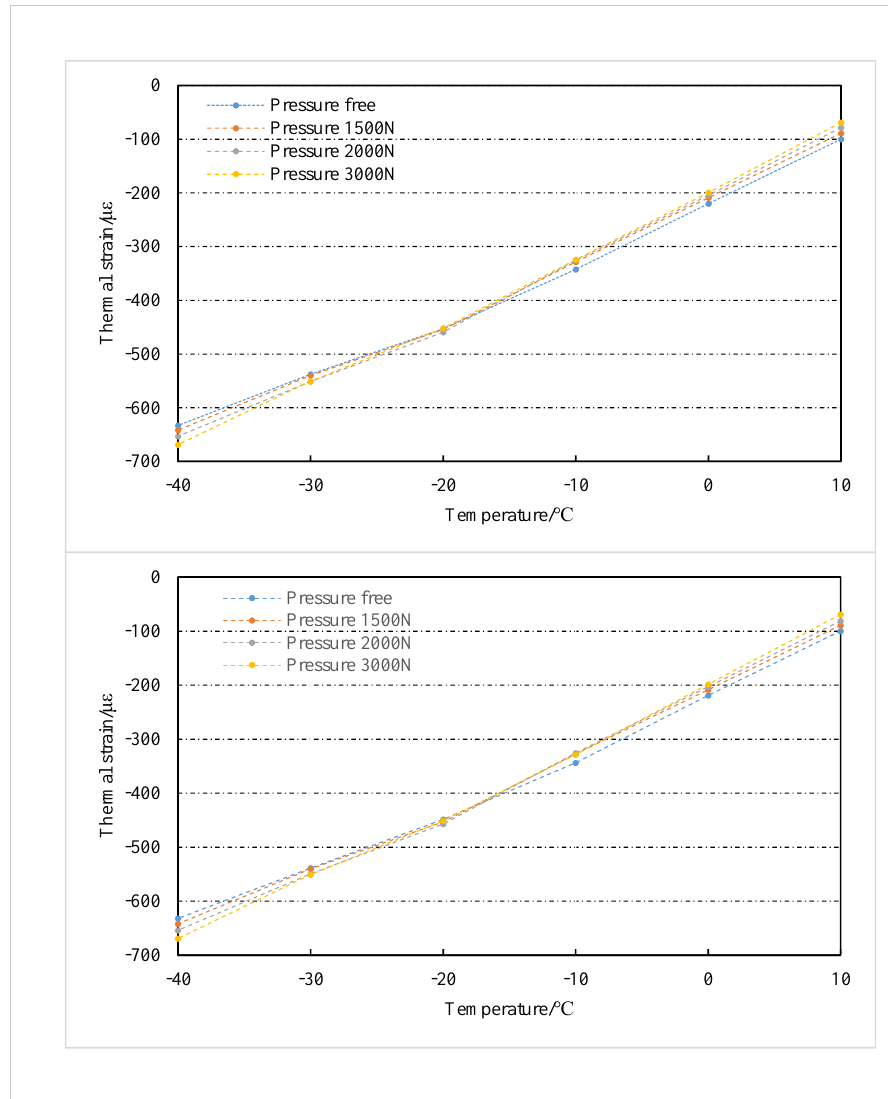
Figure 11. Thermal strain of detection 1 and detection 2 in each pressure